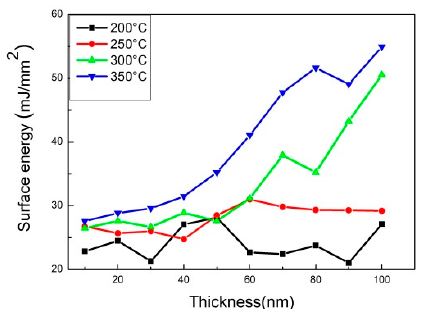
Figure 7. The surface energy of CoFeWB thin films. Table 3. Significant properties for Si(100)/Co 40 Fe 40 V 10 B 10 and Si(100)/Co 40 Fe 40 W 10 B 10 materials. Table 2. Comparing contact angle and surface energy for Co 40 Fe 40 W 10 B 10 thin films from different fabrication processes.